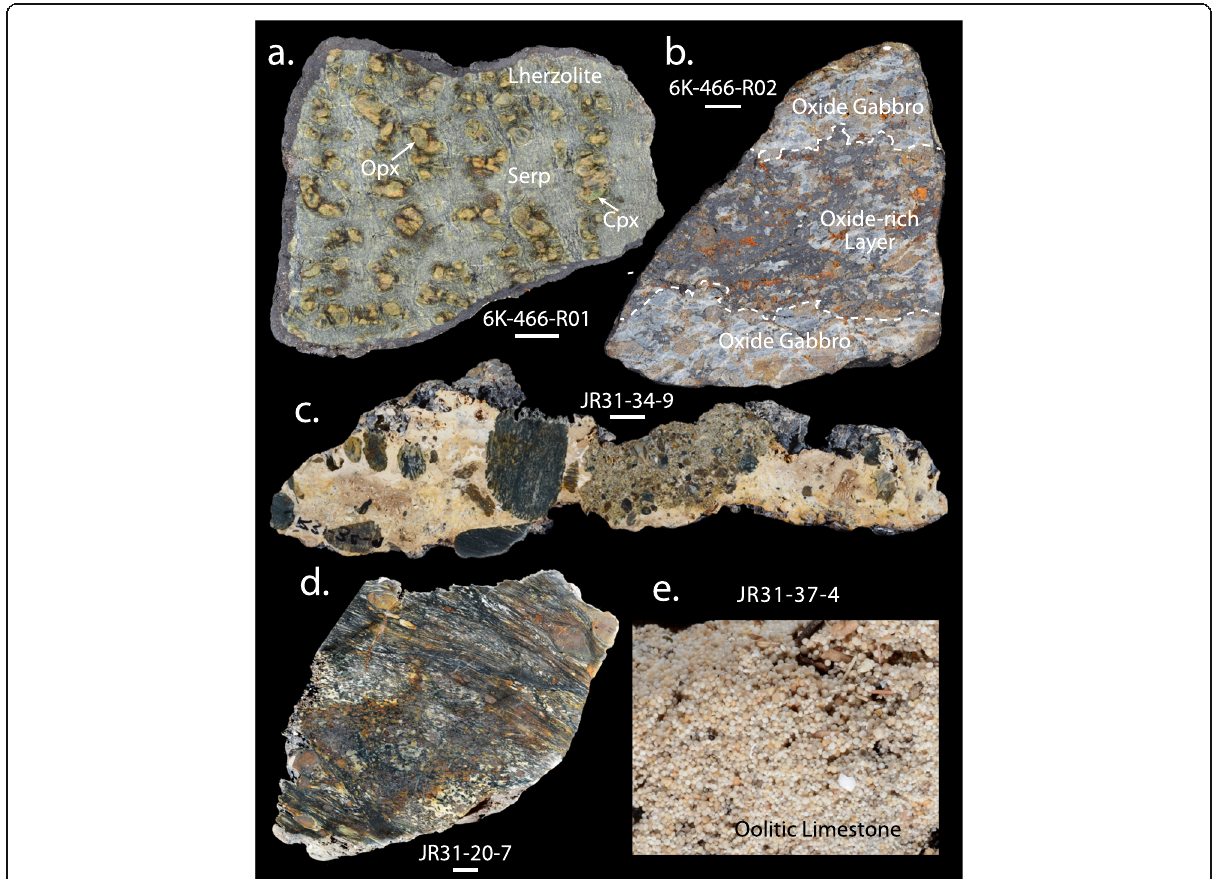
Fig. 25 Selected samples from Dives 466 and James Clark Ross Cruise 31 Dredges 20, 34, and 37 (see Fig. 3). a Porphyroclastic granular lherzolite (C-P 1) from 4714 m depth below the gabbro-mantle contact, with serpentine replacing olivine, but only minor replacement of enstatite and diopside (green pyroxene on lower left). b Moderately deformed (C-P 1.0) layered oxide-rich olivine gabbro from above the gabbro-mantle contact at 4614 m depth. c Bioclastic limestone cemented conglomerate from an old submerged shoreline on the western perimeter of the wave-cut platform at 934 m, with serpentinite, gabbro, poorly sorted sandstone, and milky quartz cobbles and clasts. d Partially amphibolitized olivine gabbro mylonite and augen gneiss from the eastern flank of the wave-cut platform. Note the deep pitting of the edges of the slabs interpreted as due to sub-aerial and shallow marine weathering, particularly on the edge of the otherwise well-rounded gneiss cobble in